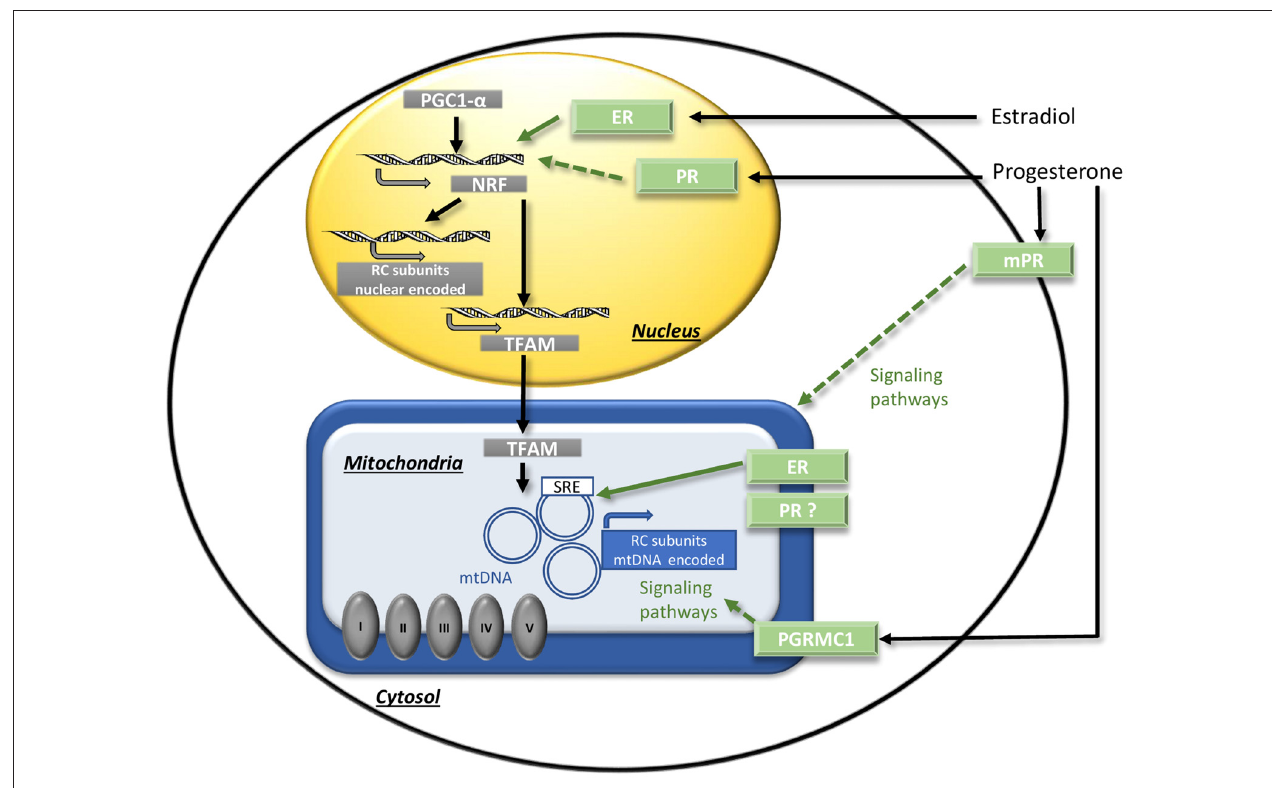
FIGURE 3 | The regulation of mitochondrial function by sex steroids. The binding of estradiol to the nuclear receptors ER activates transcriptional factors (NRF/PGC1- α ) that induce the expression of nuclear DNA-encoded RC subunits and of transcription factor A (TFAM). TFAM induces the expression of mitochondrial DNA (mtDNA)-encoded RC subunits. Direct transcriptional effects on mtDNA mediated by mitochondrial ER receptors could also occur. Concerning progesterone, the potential mechanisms have to be investigated. Putative signaling effects via NRF/PGC1- α activation by nuclear PR, or via membrane receptors mPR or PGRMC1 are represented by dotted arrows. ER, estrogen nuclear receptors; mPRs, progesterone membrane receptors; mtDNA, mitochondrial DNA; NRF, nuclear respiratory factor; PGC1- α , peroxisome proliferator-activated receptor gamma co-activator 1 α ; PGRMC1, progesterone receptor membrane component 1; PR, progesterone nuclear receptor; RC, respiratory chain; SRE, steroid response element; TFAM, mitochondrial transcription factor A. Adapted from Gaignard et al.